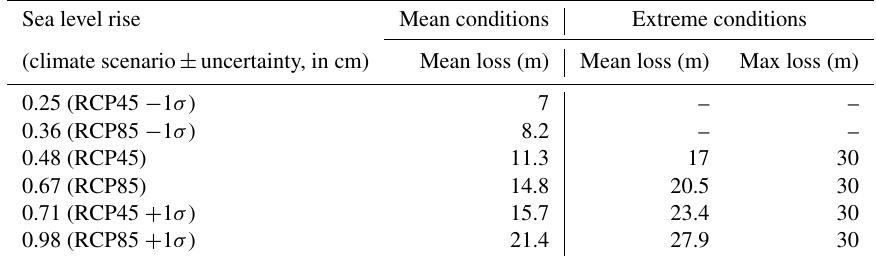
Table 7. Loss of aerial beach (defined here as the landward migration of the shoreline averaged over the entire beach) for both the mean and extreme conditions expected under climate change scenarios in Playa de Palma (in m). For the extreme conditions, the maximum loss is also